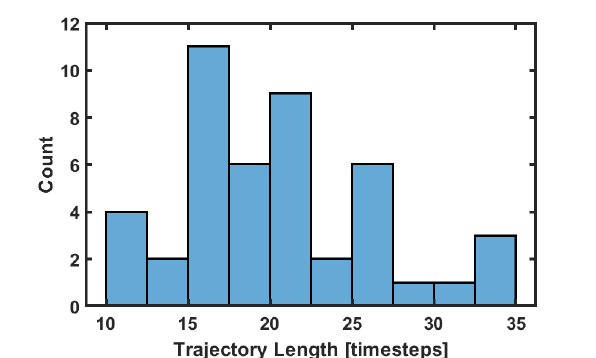
Figure 9. Histogram of trajectory length, defined as the number of frames where the fragment belonging to the trajectory was identified. Since the image sequence was 40 frames, some fragments were tracked over nearly the entire length of the recording.